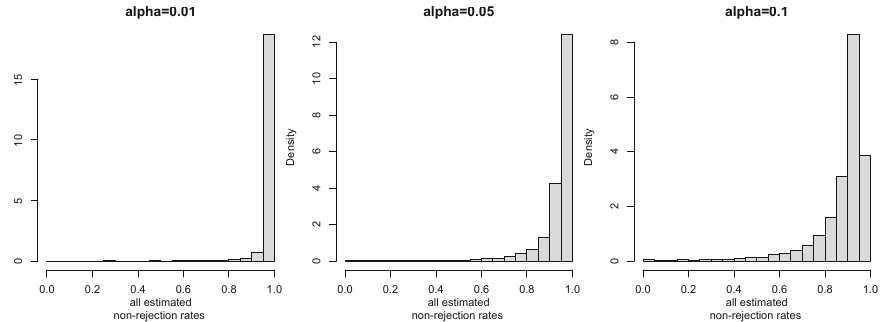
Figure 1 – qp -hist plots for